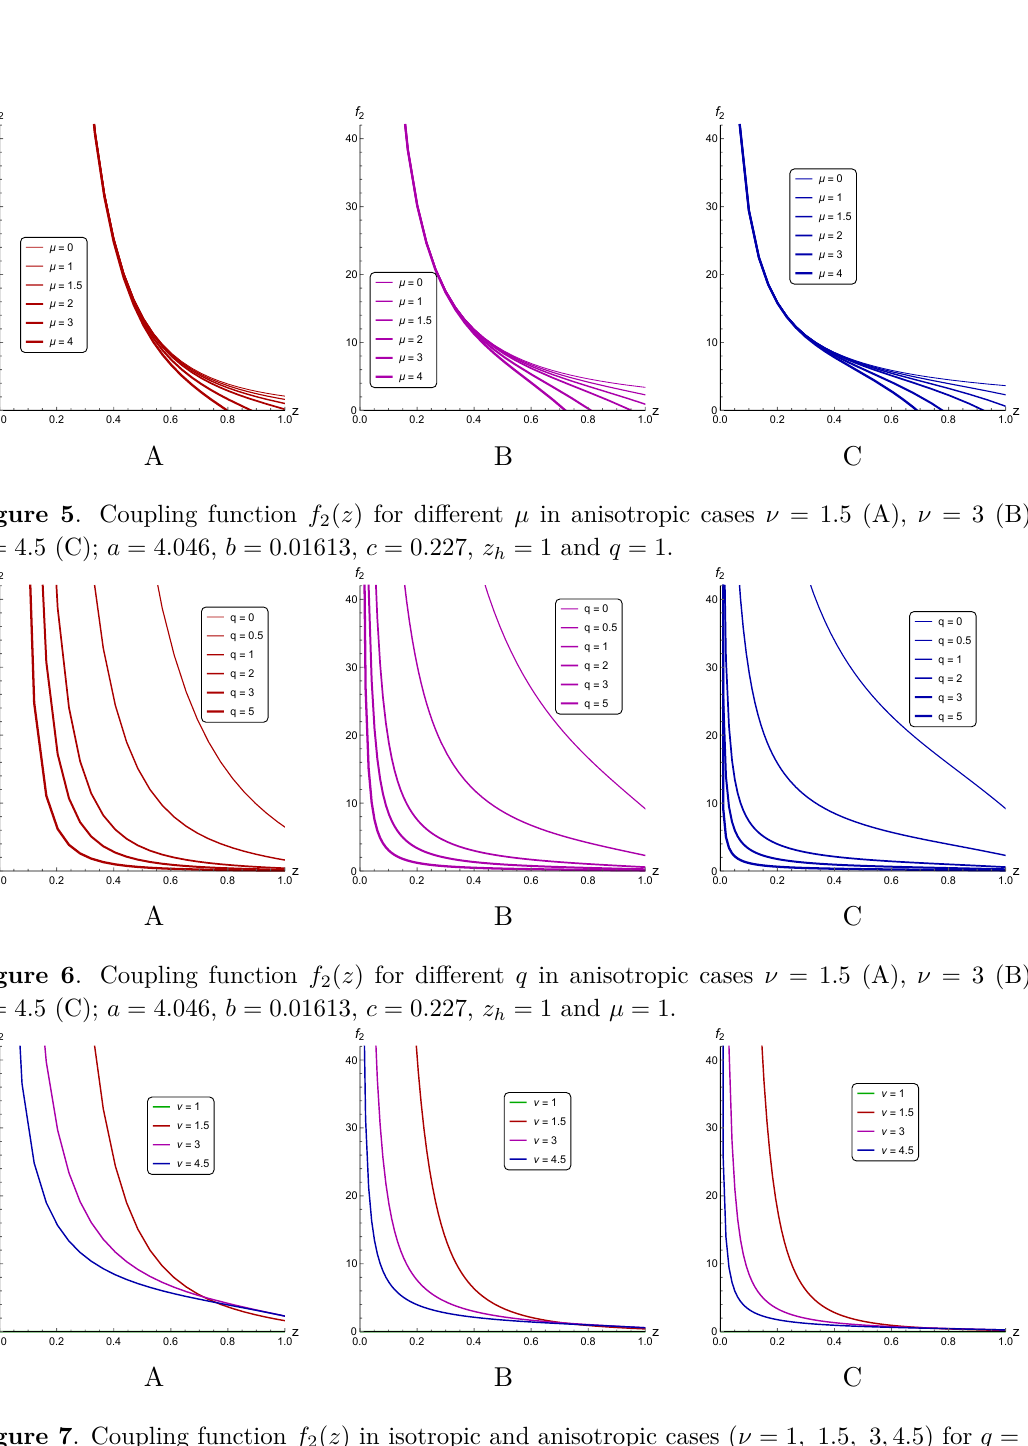
Figure 7 . Coupling function f 2 ( z ) in isotropic and anisotropic cases ( ν = 1 , 1 . 5 , 3 , 4 . 5 ) for q = 1 (A), q = 2 (B), q = 3 (C); a = 4 . 046 , b = 0 . 01613 , c = 0 . 227 , z h = 1 and µ = 1